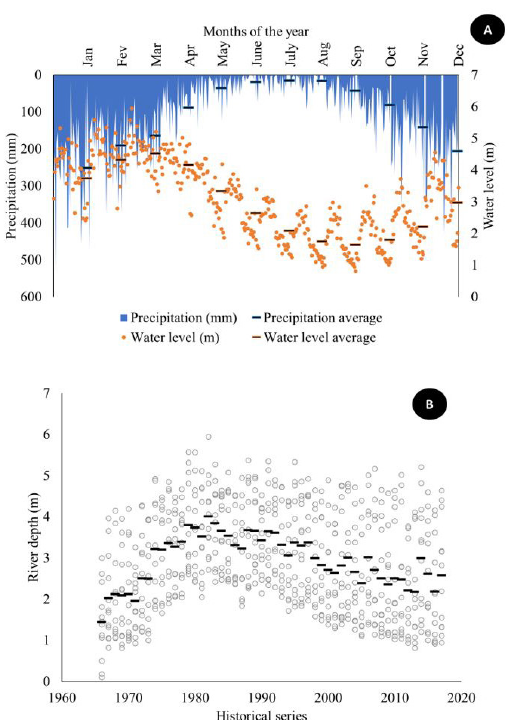
Figure 5. Monthly precipitation and Paraguay river water level in the Northern Pantanal from 1971 to 2013 (A); and Annual Paraguay river depth in the same region from 1971 to 2013 (B) showing the flood pulse of the waters. Black dashes represent the annual